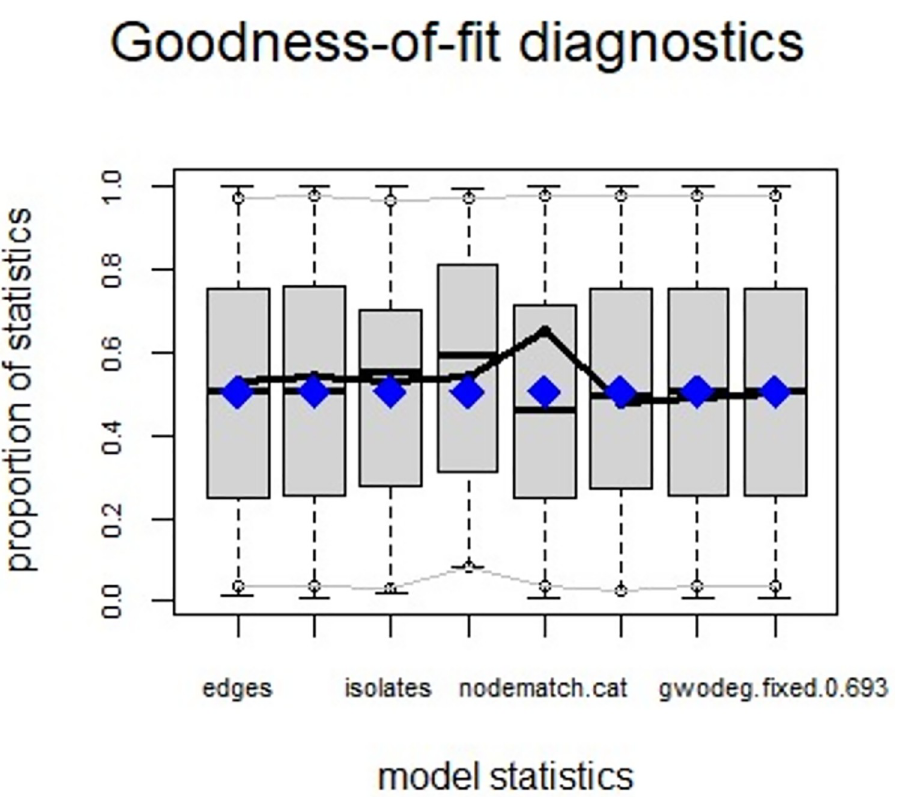
Fig 12. Multiplexity in the beta community–goodness of fit [24] model statistics.